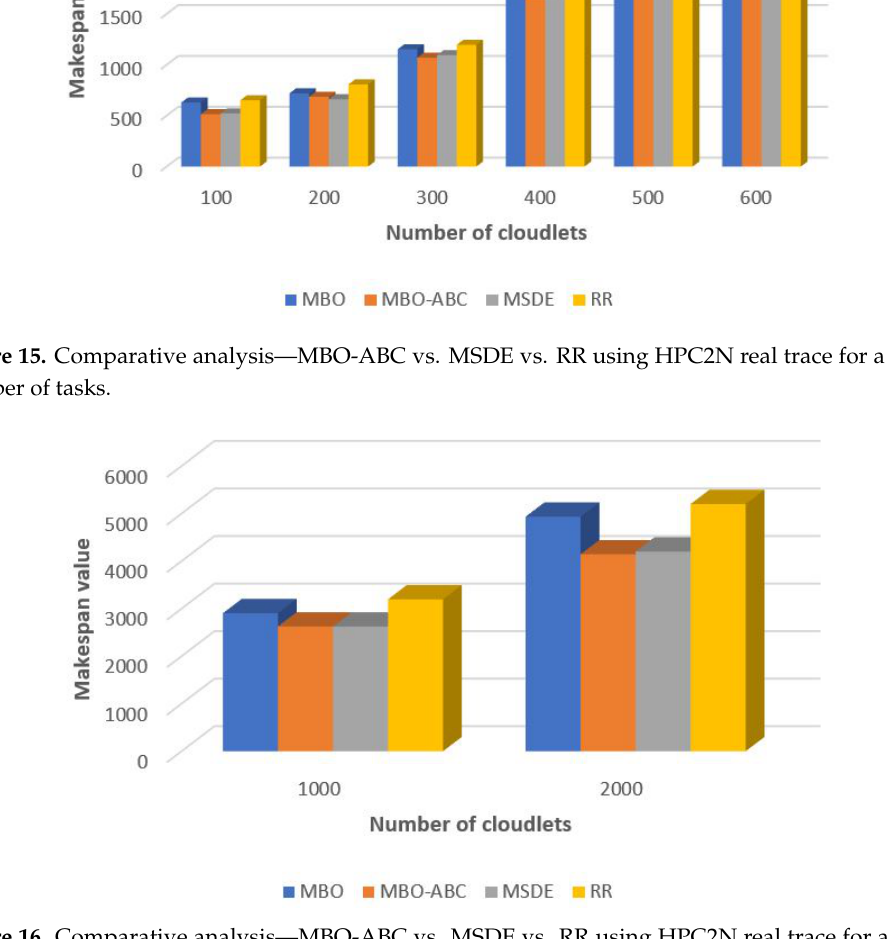
Figure 16. Comparative analysis—MBO-ABC vs. MSDE vs. RR using HPC2N real trace for a large number of tasks.